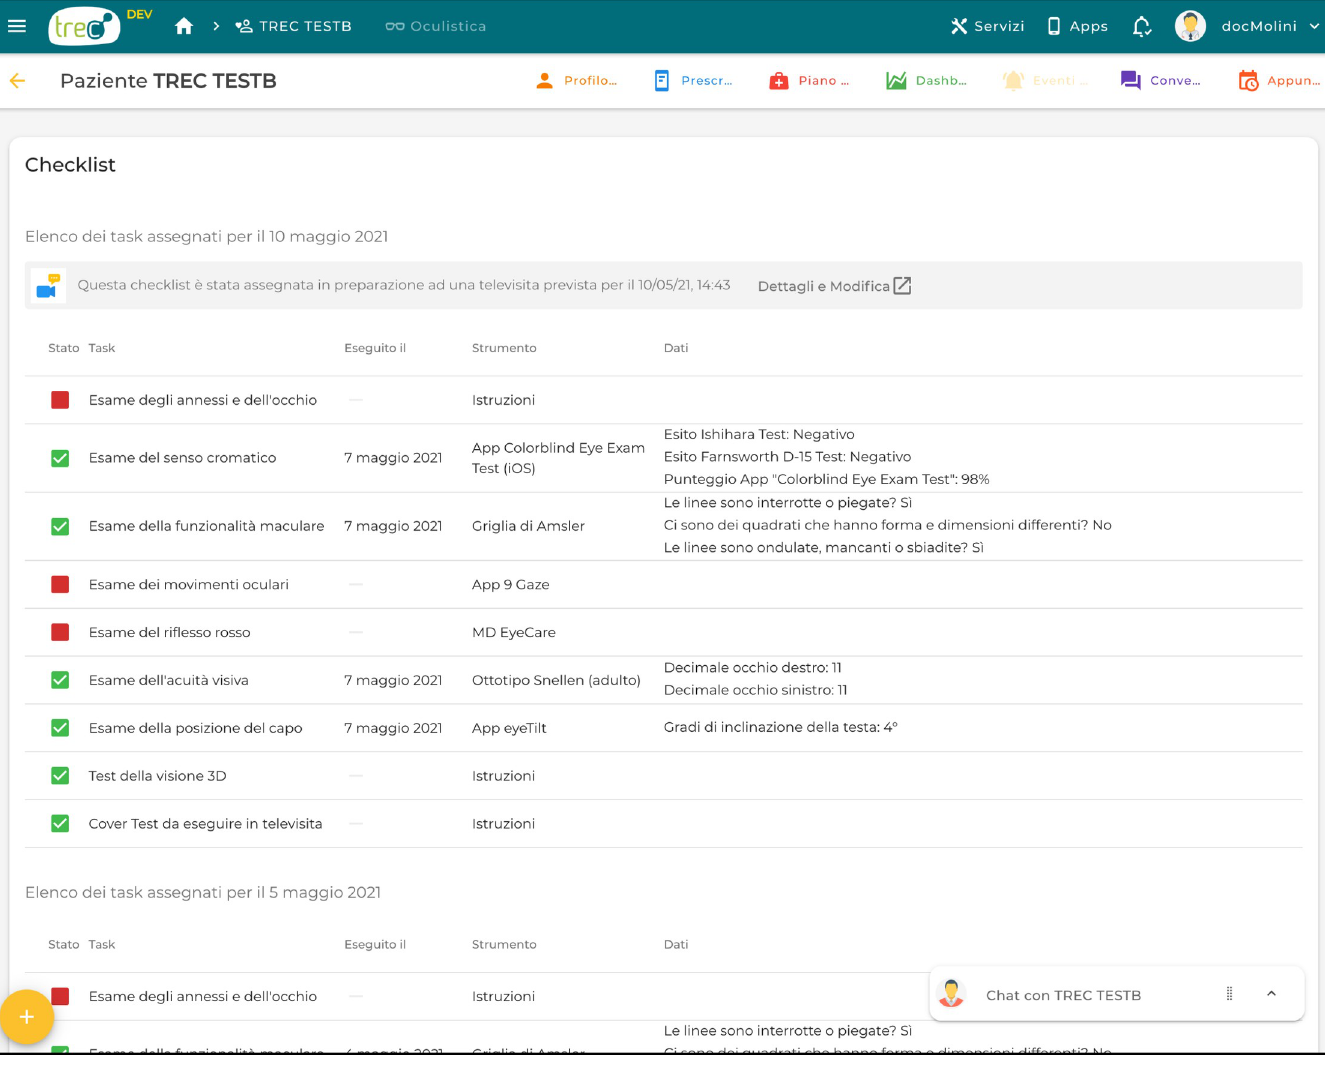
Fig 3. Clinical dashboard: For each scheduled televisit, the list of the requested measurements is displayed within a structured grid in the clinical dashboard. For each televisit, clinicians can visualize the state of the task (completed: green square; non-completed: red square), the name of the measurement, the data entry date, the suggested material, the patient’s data uploaded on the